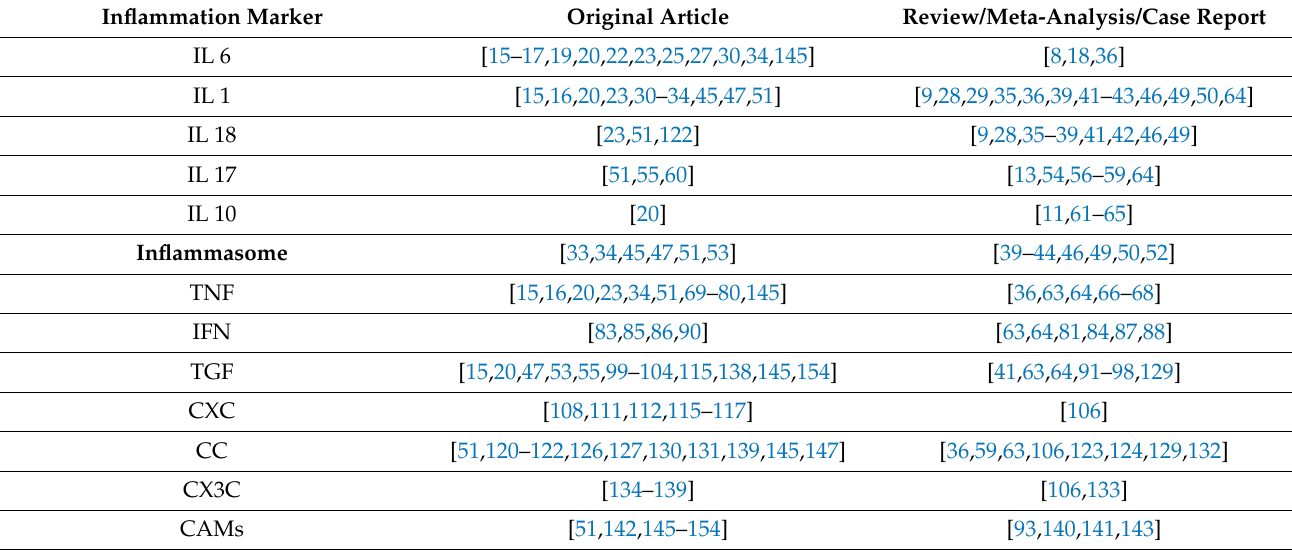
Table 1. Reference list of articles after 2015 mentioning individual inflammation markers. Inflammation